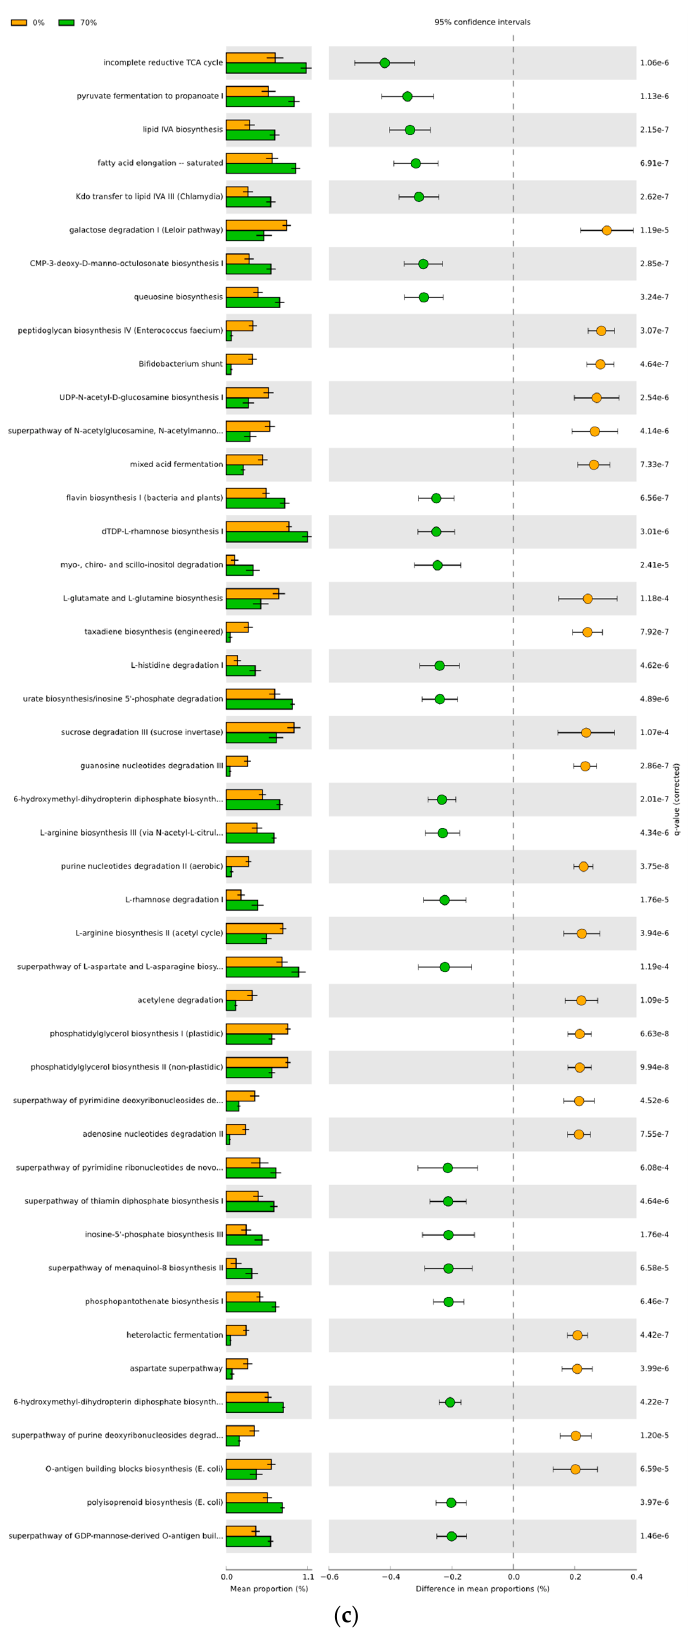
Figure 8. PICRUSt2 results indicating differential predicted functional pathways with 20% of the difference in the mean proportions between the bean-free and the bean-containing diet groups